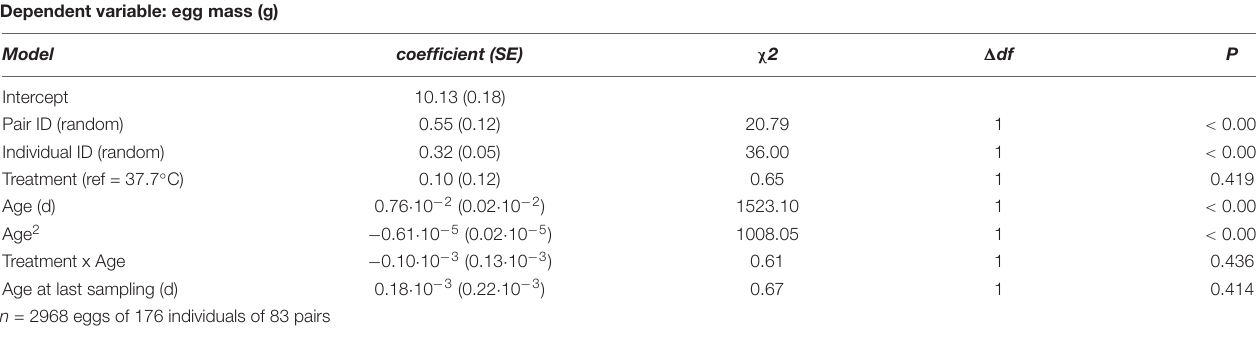
TABLE 5 | Summary of a linear mixed model testing for effects of incubation treatment on age-specific egg mass in Japanese quail females.